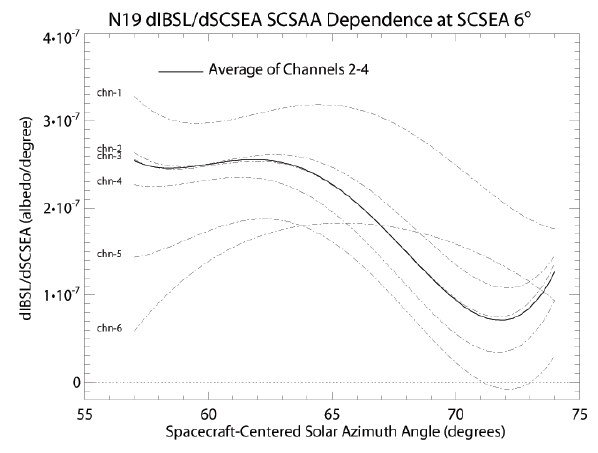
Fig. 17. The sample of IBSL effects in the retrieved ozone profiles near the North Pole is taken from an average of two weeks around the spring equinox 2010. Twenty-one SBUV V8 profile layers are defined by 10 − 2 n atmosphere pressure levels, where n starts from 0 for the bottom boundaries. Only top layers above 10hPa are labeled. Other lower layers overlap each other within 2%. The black curve for the total column ozone difference is near